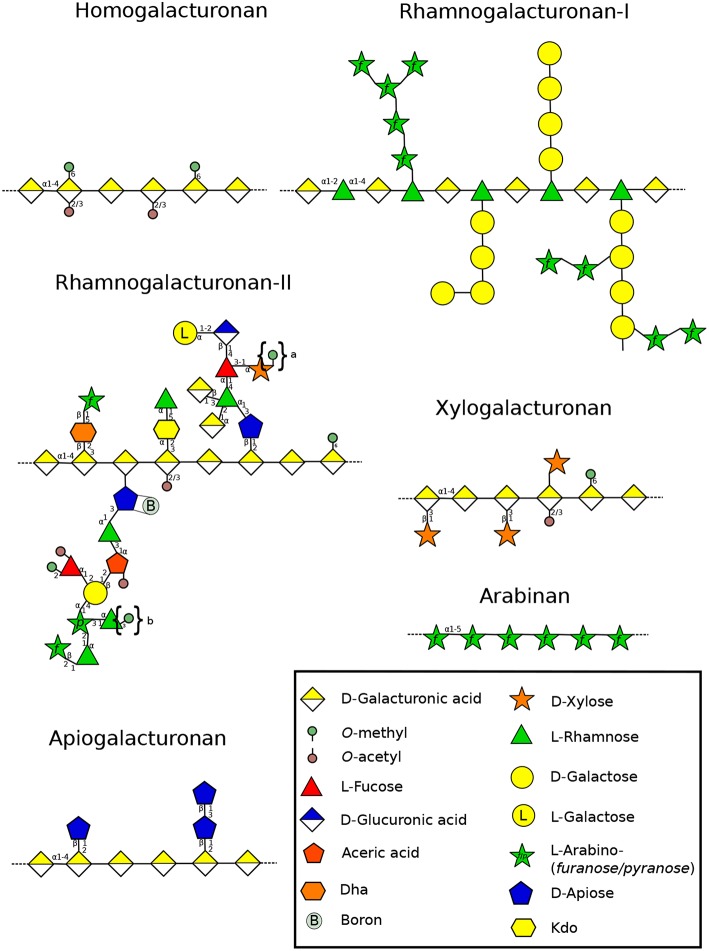
Structure of the different pectin domains found in the cell wall throughout land plant lineages (Wolf et al., 2012). The structural changes of RG-II side chains is presented according to Matsunaga et al. (2004), O'Neill et al. (2004), Pabst et al. (2013), and Ndeh et al. (2017). Linear arabinans were described in N. alata pollen tubes (Lampugnani et al., 2016). Symbols in braces represent methyl decorations: “a,” 0, 1, or 2 methylester(s) that can be found in Lemnoidae, and “b,” methylesters found only in bryophytes (Matsunaga et al., 2004; Avci et al., 2018). Dha: 3-Deoxy-D-lyxo-hept-2-ulopyranosaric acid, Kdo: 3-Deoxy-D-manno-oct-2-ulopyranosonic acid. Monosaccharides are represented according to the Symbol Nomenclature for Glycans (SNFG) (Varki et al., 2015).